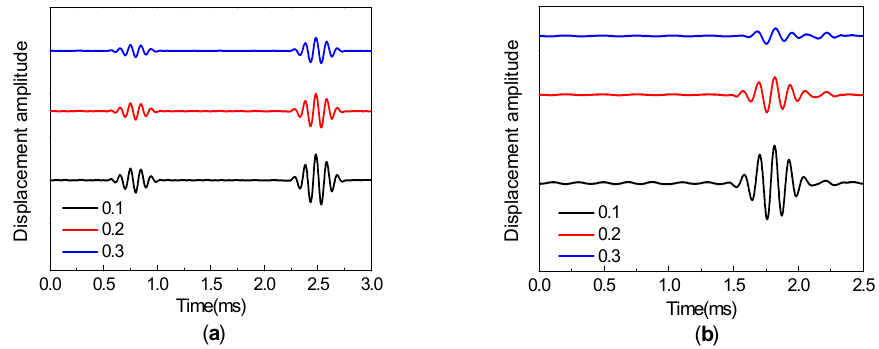
Figure 9. Time-domain waveforms with respect to time for various values of porosity in an infinite porous medium ( a ) at the liquid–pipe interface and ( b ) at the external interface of the finite porous medium. The thickness of finite porous medium is d = 0.05 m. Black, red, and blue lines represent the porosity values of β = 0.1, 0.2, and 0.3,